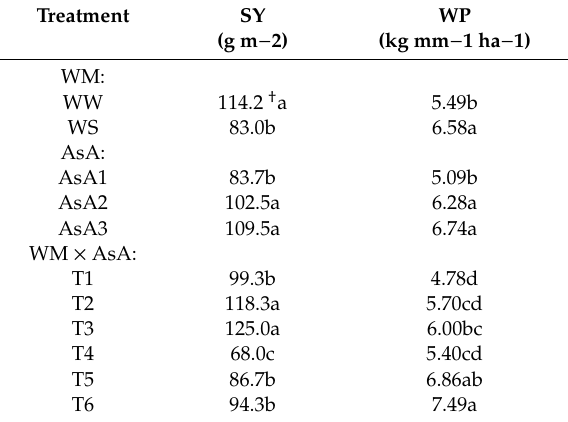
7.49a † Mean values within the same column for each trait with the same lower-case letter are not significantly di ff erent according to Tukey’s HSD (honestly significant di ff erence) test at p ≤ 0.05. Measurements were done at 46 day after sowing. WW, well watered with 100% of evapotranspiration (ETc) throughout the season; WS, water stress